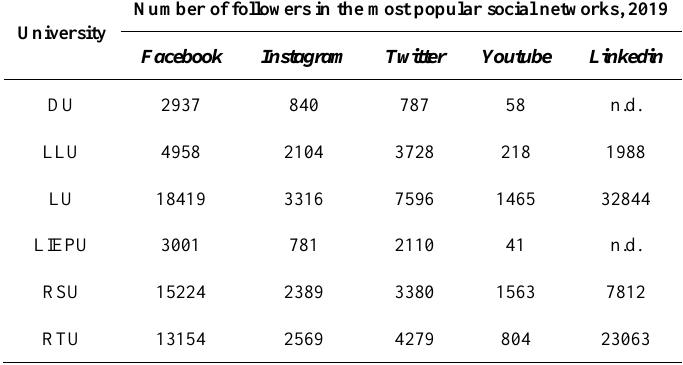
Table 1. Latvia public universities in social networks, 2019.